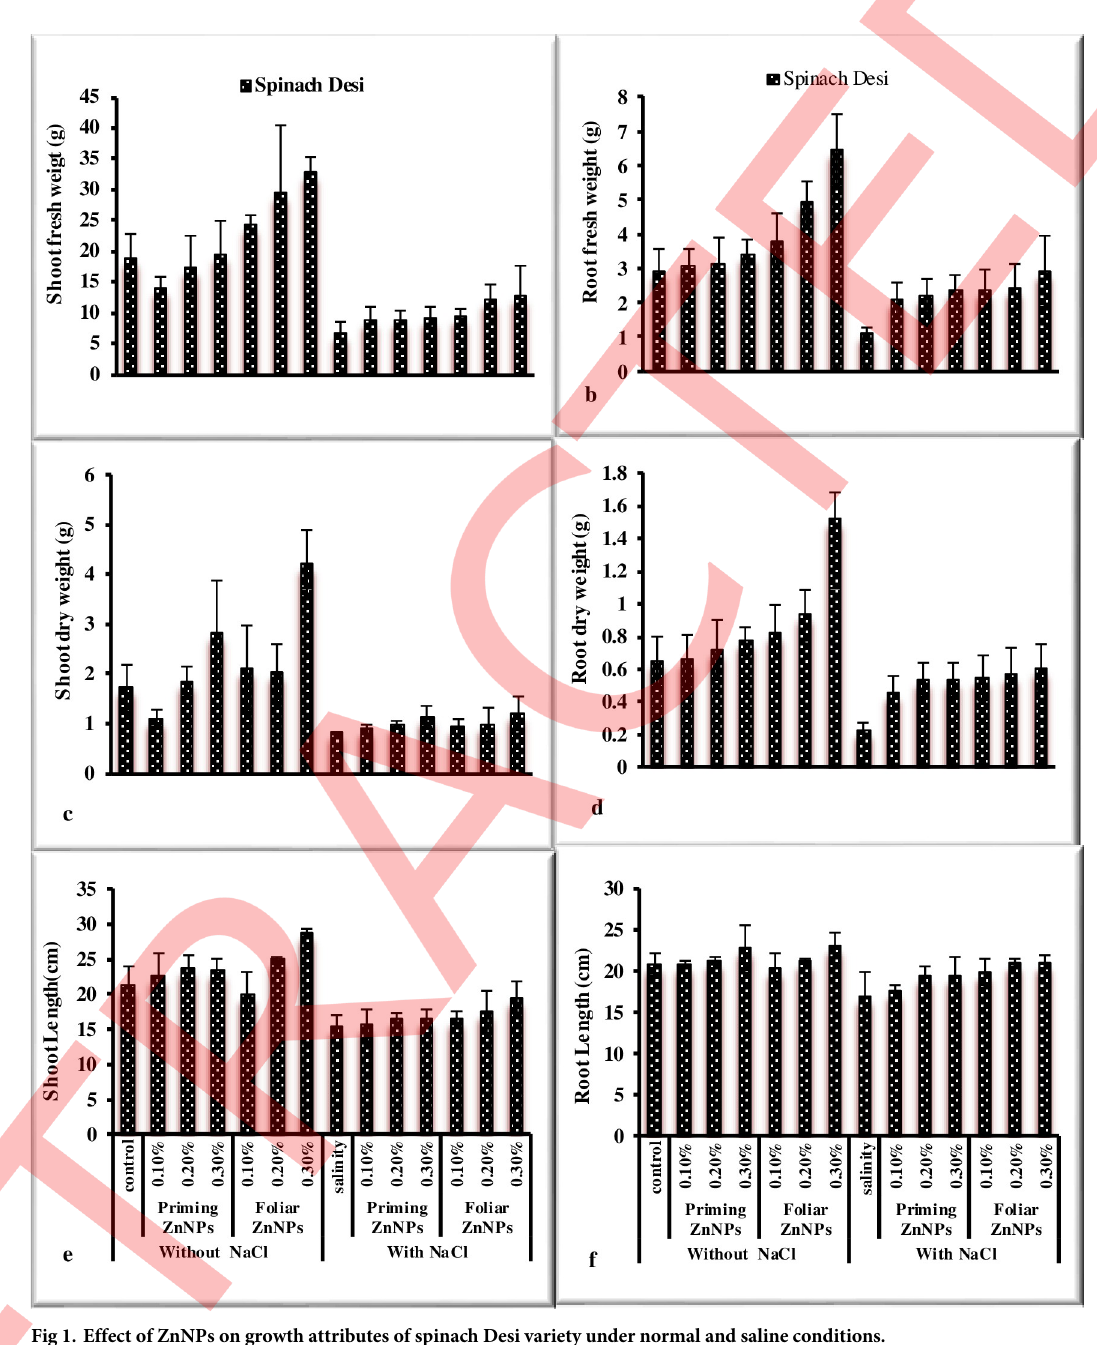
Fig 1. Effect of ZnNPs on growth attributes of spinach Desi variety under normal and saline conditions.